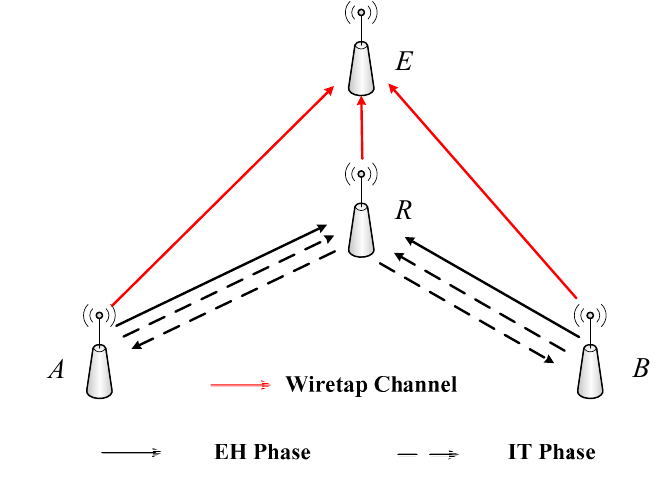
Figure 1. The relaying network model.